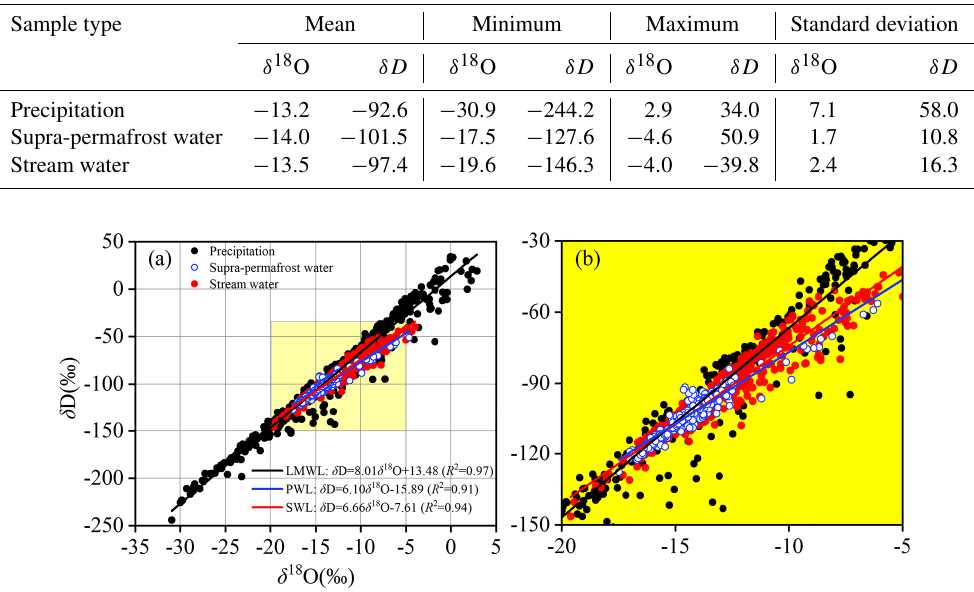
Figure 3. Relationships between δ 18 O and δD of precipitation, stream water, and supra-permafrost water. (a) All isotope data; (b) the data, constrained by a yellow square.